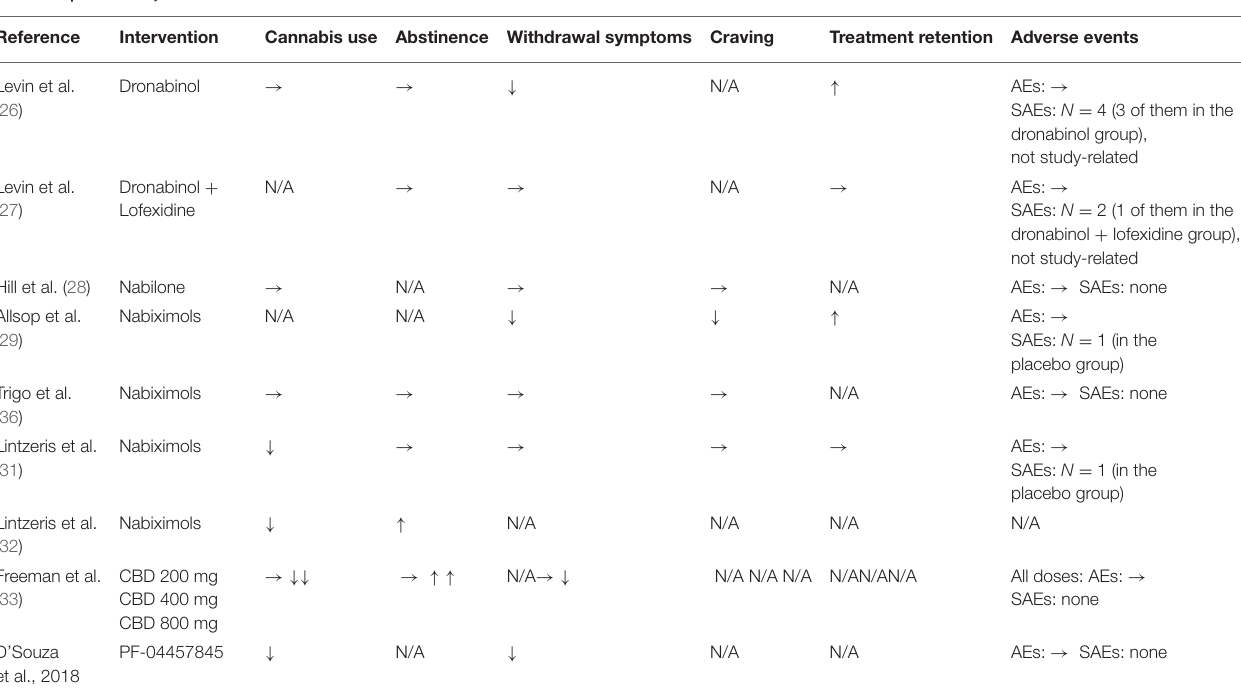
TABLE 3 | Main study outcomes.